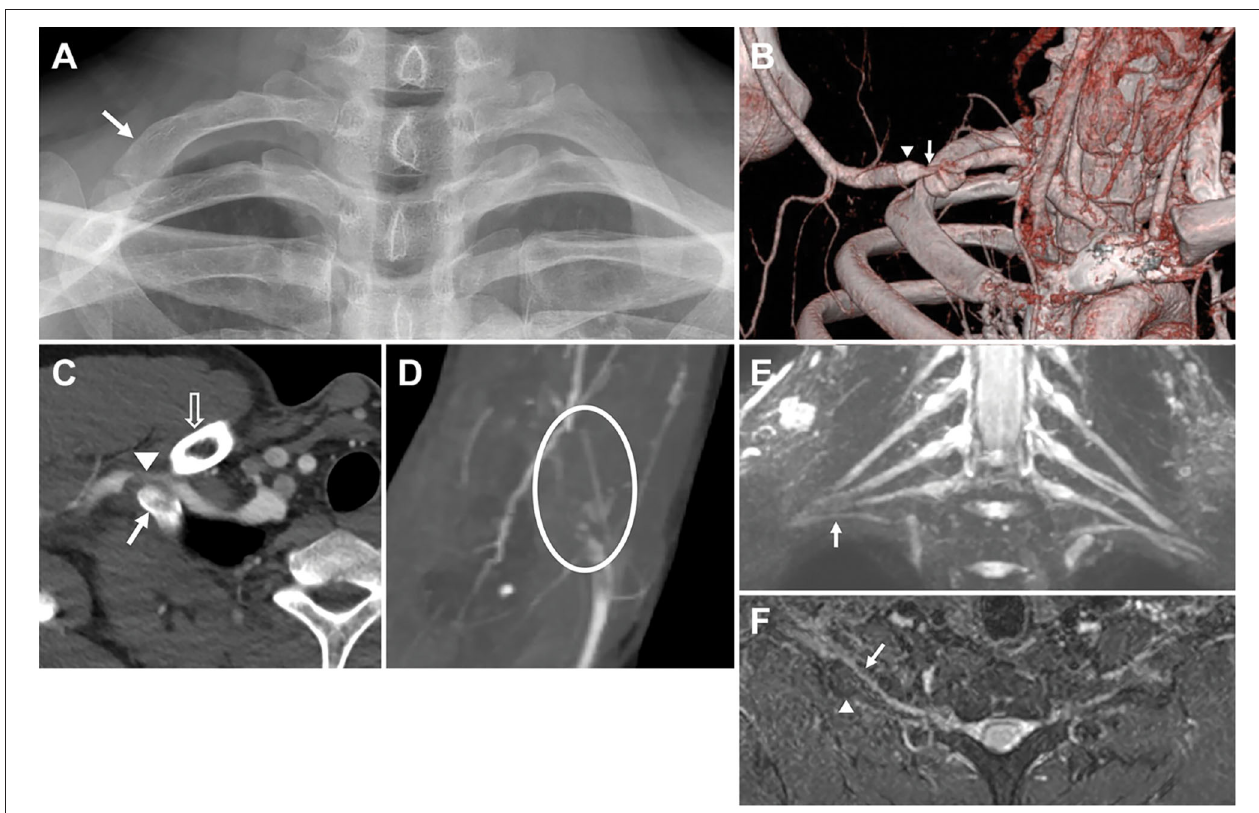
FIGURE 2 | Imaging findings for Patient 2. (B–D) Computed tomography (CT) angiography performed with 180 ◦ shoulder abduction. (E,F) Brachial plexus magnetic resonance imaging (MRI). (A) Plain radiograph of the cervical spine showing upwardly convex curvature and an anomaly of the right first rib (arrow). (B) When viewed from the front, a reconstruction image using volume rendering shows stenosis (arrow) and post-stenotic dilatation (arrowhead) of the right subclavian artery. (C) Axial image showing the spatial relationships of the anomalous right first rib (arrow) articulating with the second rib, narrowed subclavian artery (arrowhead), and clavicle (voided arrow). (D) Maximum intensity projection (MIP) image showing thromboembolic occlusion of the right brachial artery at the elbow level (circle). (E) Coronal T2-weighted fat suppression MIP image showing a high-riding right T1 extraforaminal root and lower trunk (arrow) compared to those on the opposite side. Abnormal signal intensity of the brachial plexus was not definite. (F) Axial T2-weighted fat suppression MIP image showing anterior angulation of the right lower trunk (arrow) by the anomalous right first rib